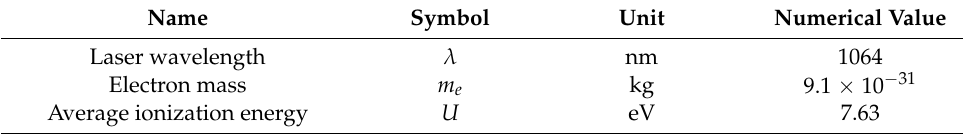
Table 2. Calculation